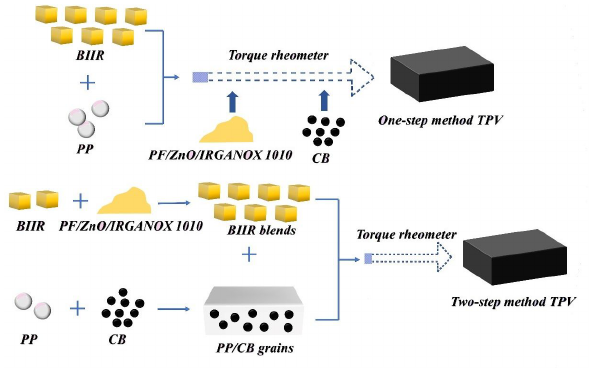
Figure 1: Schematic illustration of the processing